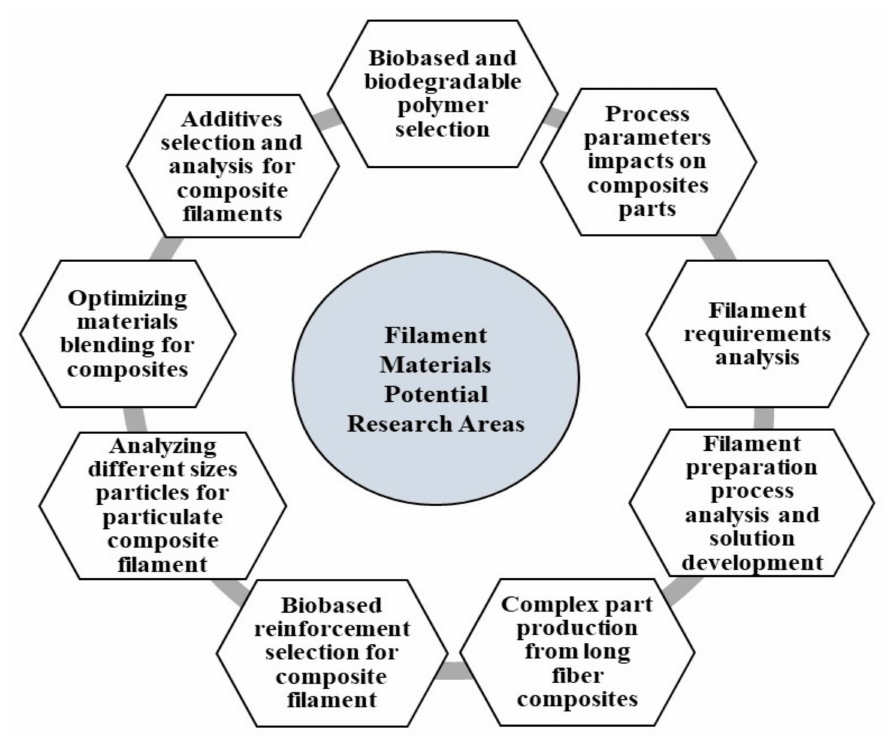
Figure 13. Future research direction for FFF filament